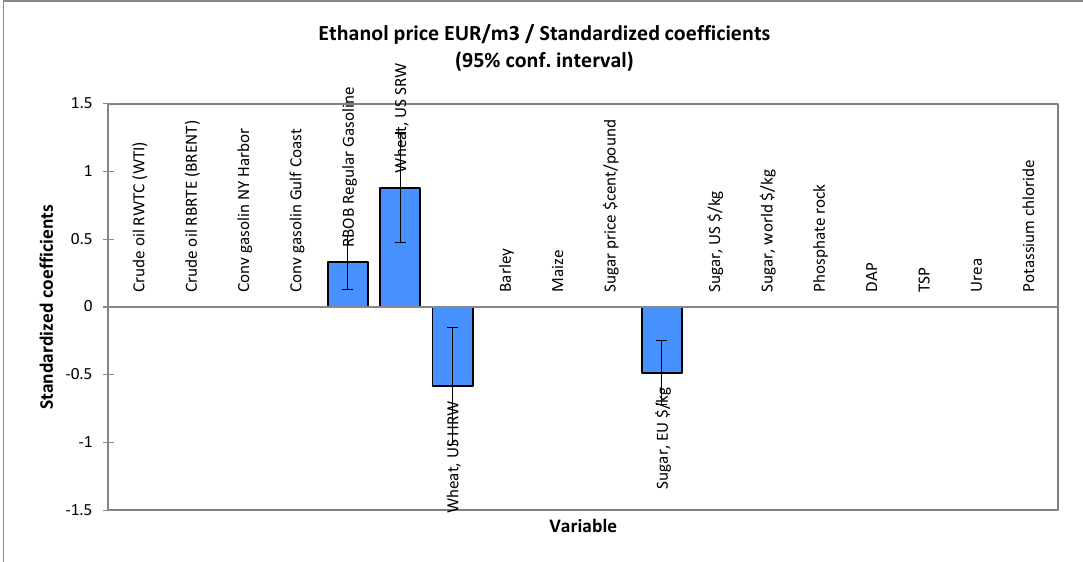
Figure 9. Impacts of the significant variables on the European ethanol price. Source: Authors’ Figure 9. ImpactsofthesignificantvariablesontheEuropeanethanolprice. Source: Authors’composition composition based on the price datasets. based on the price datasets.